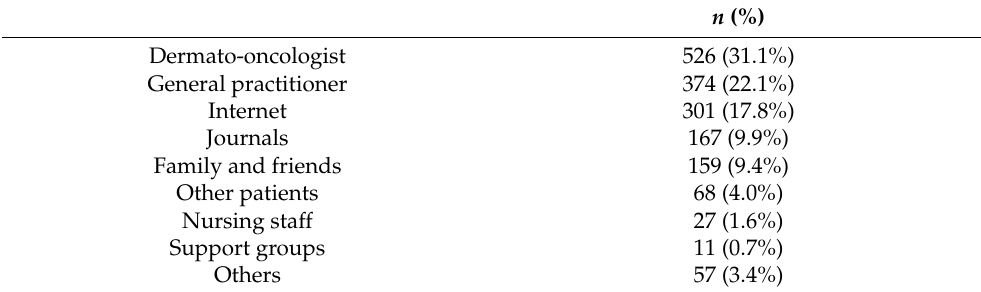
Figure 1. Age-related difference in the use of primary information. Older participants received information significantly more often from their dermato-oncologist and general practitioner. Abbrevi- ations: * p < 0.05. Table 2. Primary source of